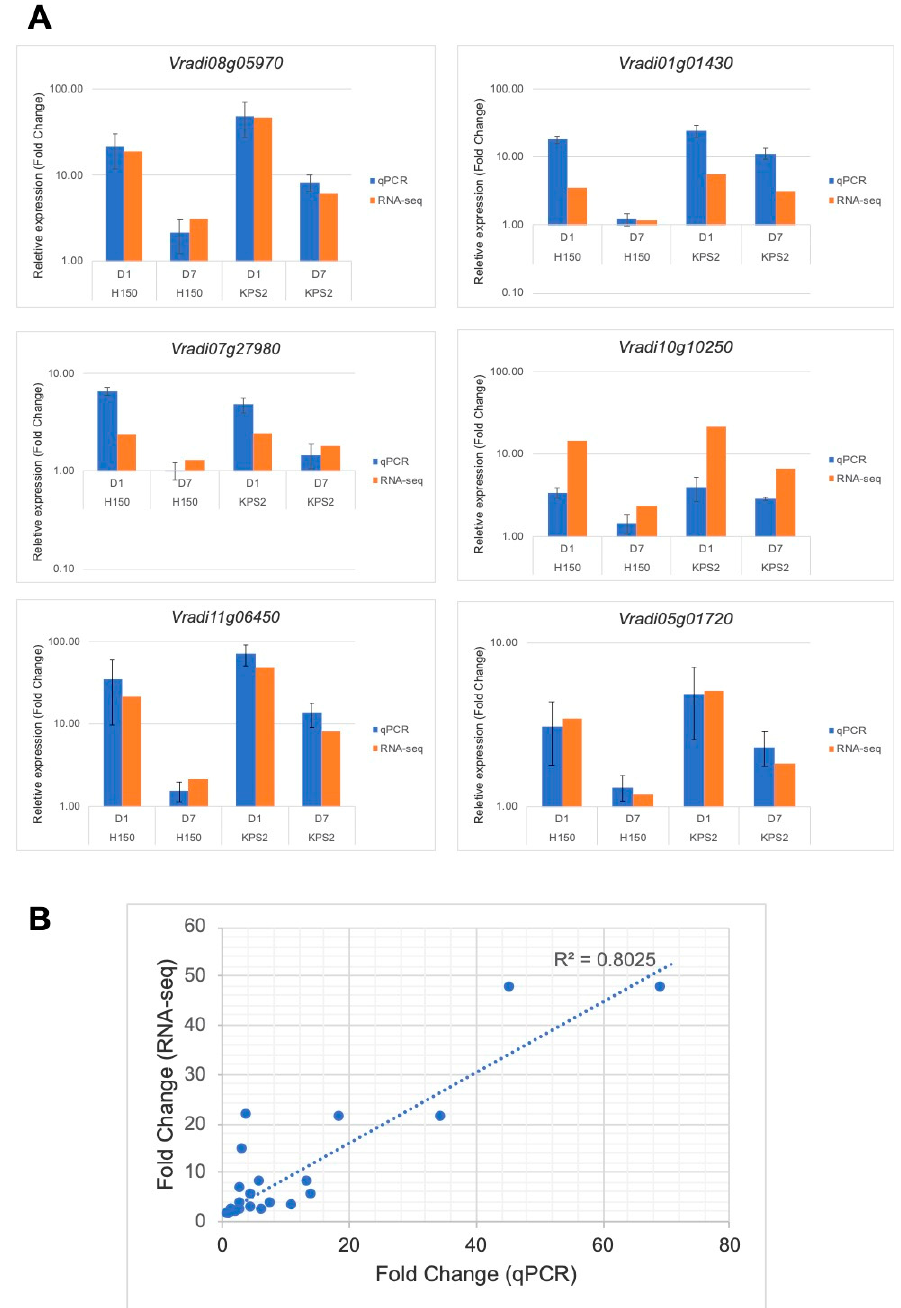
Figure 6. qPCR validation of RNA-seq data. ( A ) Comparison between qPCR and RNA-seq results for six DEGs. ( B ) Correlation between RNA-seq and qPCR data derived from six DEGs. Relative expression was normalized to the abundance of UBQ10 (Vradi0167s00180 ). Data represent mean ± SE ( n = 3).